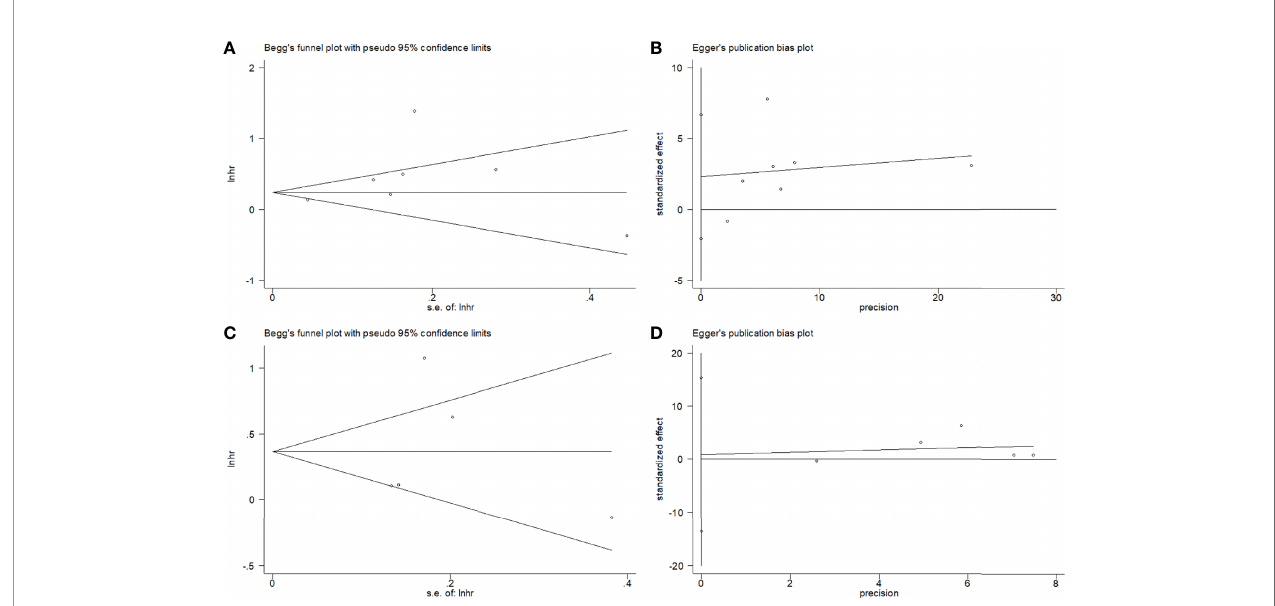
FIGURE 4 | Publication bias test by Begg ’ s funnel plot and Egger ’ s test. (A) Begg ’ s test for OS, p = 0.764; (B) Egger ’ s test for OS, p = 0.717; (C) Begg ’ s test for RFS, p = 0.463; (D) Egger ’ s test for RFS, p =